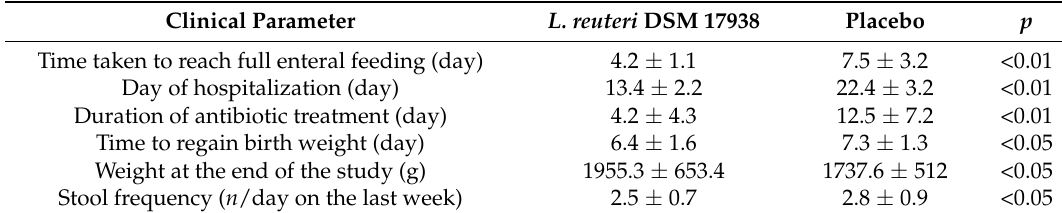
Table 2. Clinical results at the end of the study.